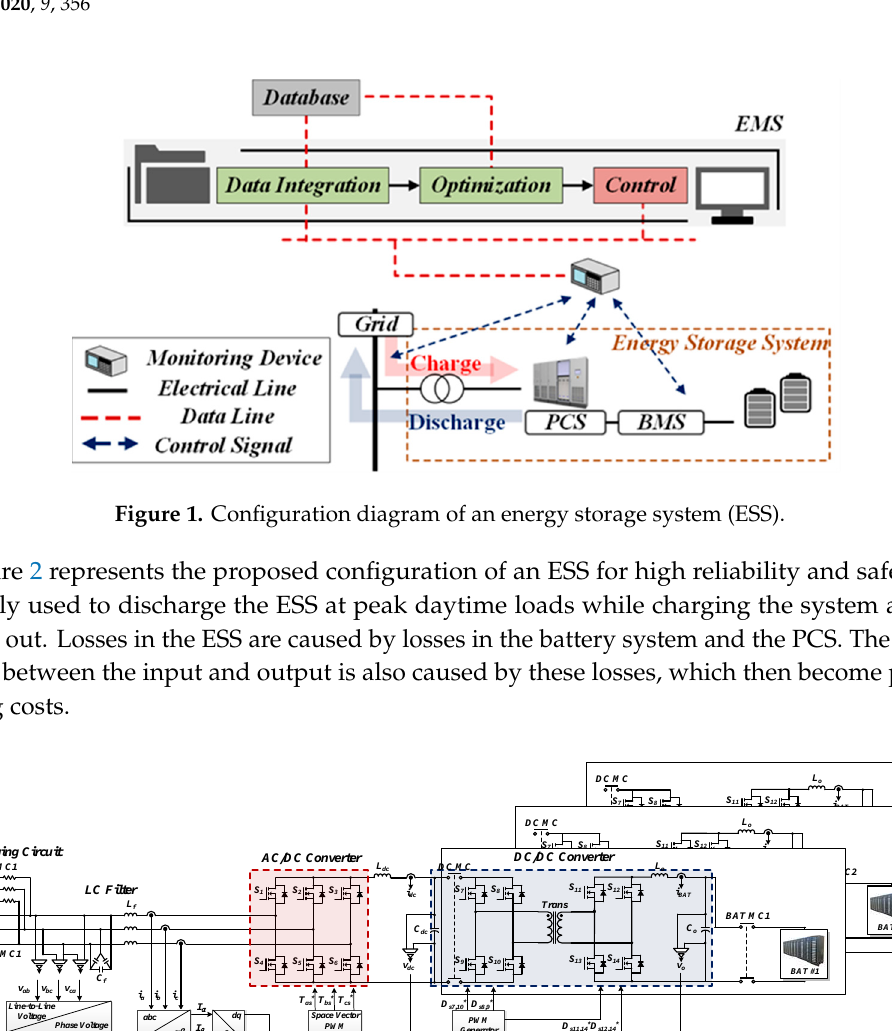
Figure 2. Proposed ESS circuit diagram.